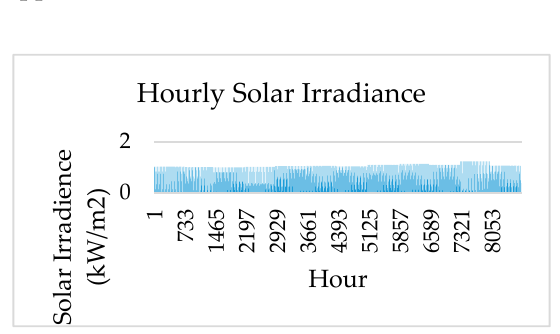
Figure A3. Hourly Solar Irradiance.